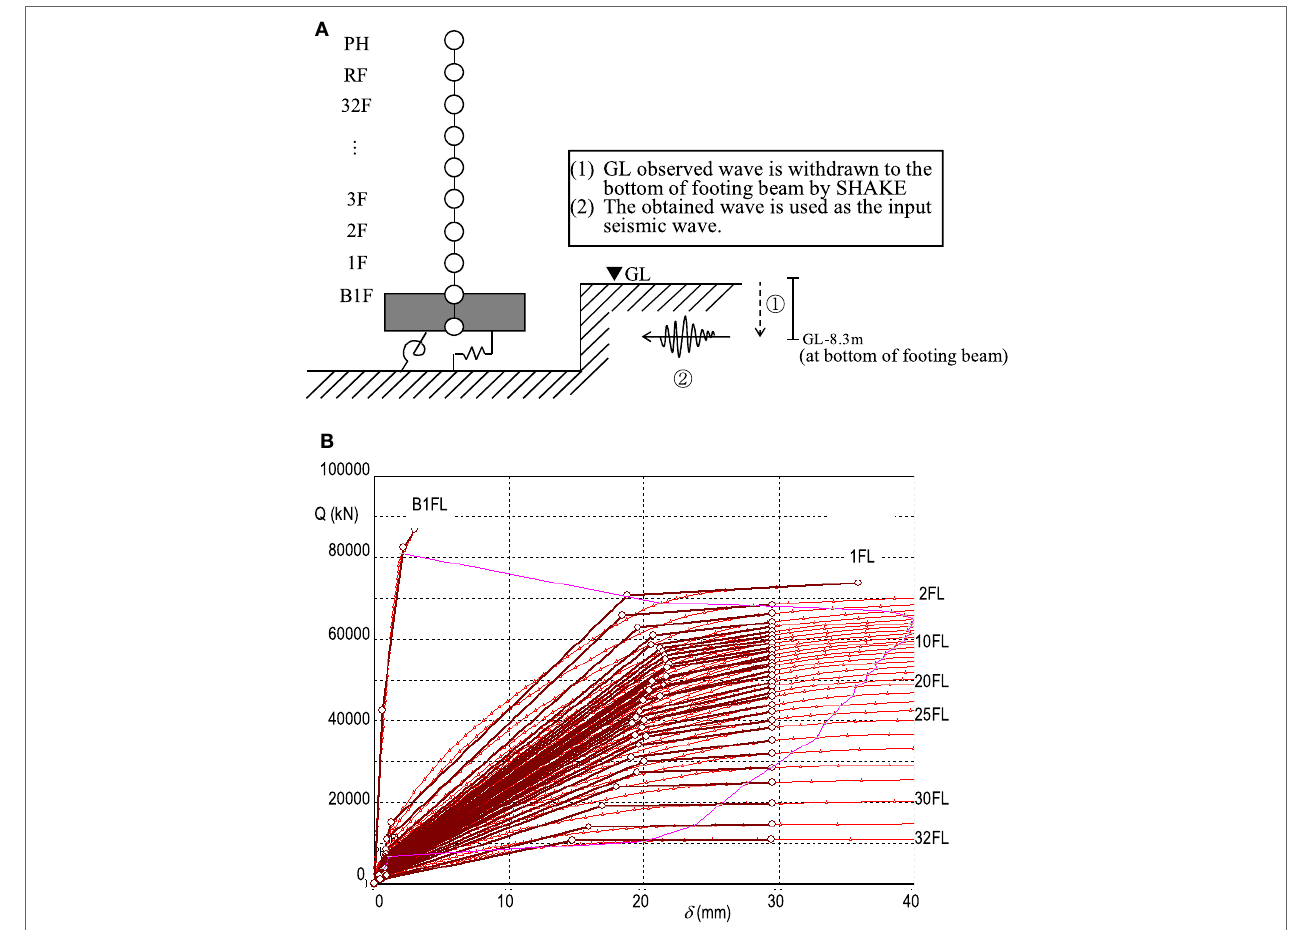
FigUre 3 | Structure model. (a) Analytical sway-rocking model, with the seismic motion input method described. (B) Skeleton curves (N–S direction) showing the first breaking point for each story, which correspond to the cracking points, and the second breaking points which correspond to the yield points.